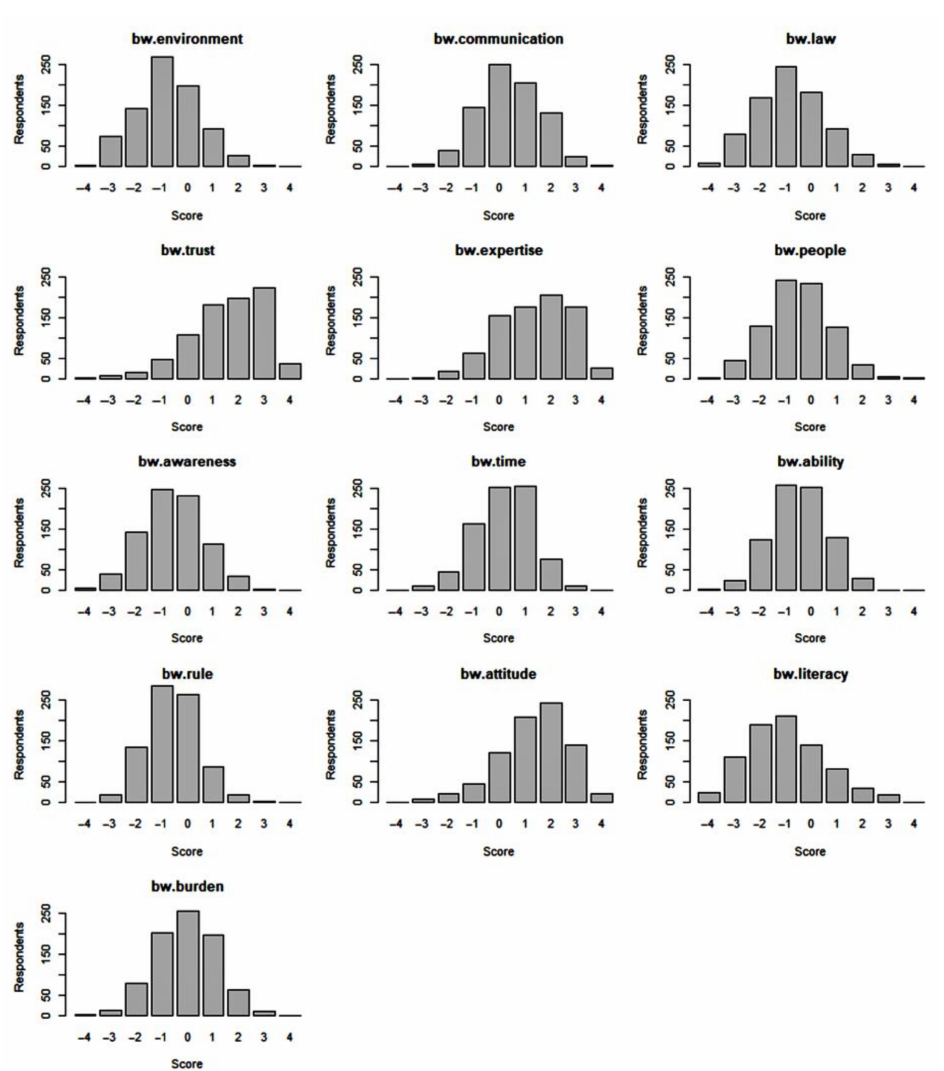
Figure 4. Empirical distribution of individual best-worst scores/bar plots of best-worst scores (BW,